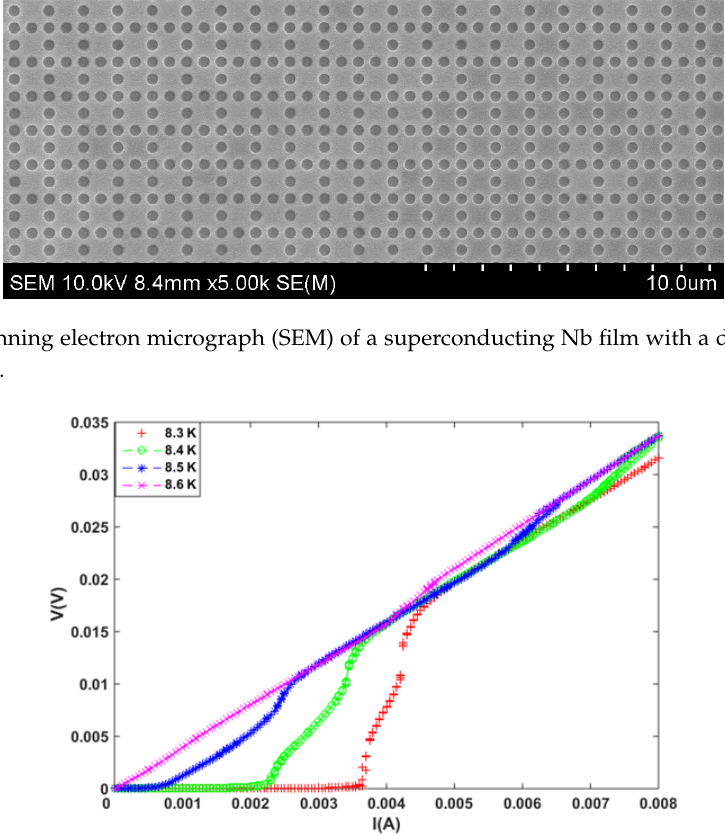
Figure 2. The current–voltage (IV) characteristic of a diluted square array of holes at different